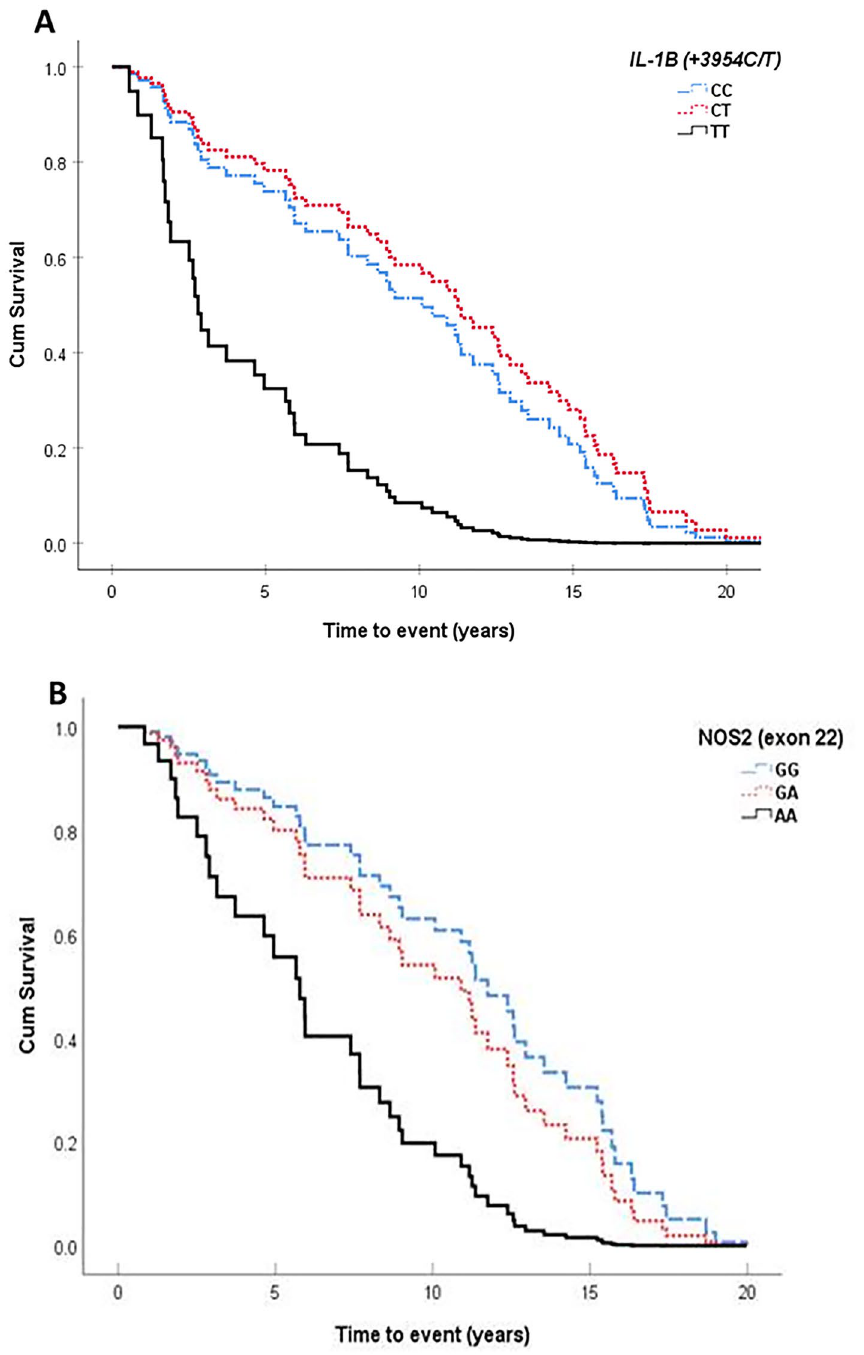
Figure 1. Cox regression curves comparing the development over time of aseptic prosthetic loosening (APL), according to the IL-1β ( + 3954 C/T) ( A ) and NOS2 (exon22) ( B )